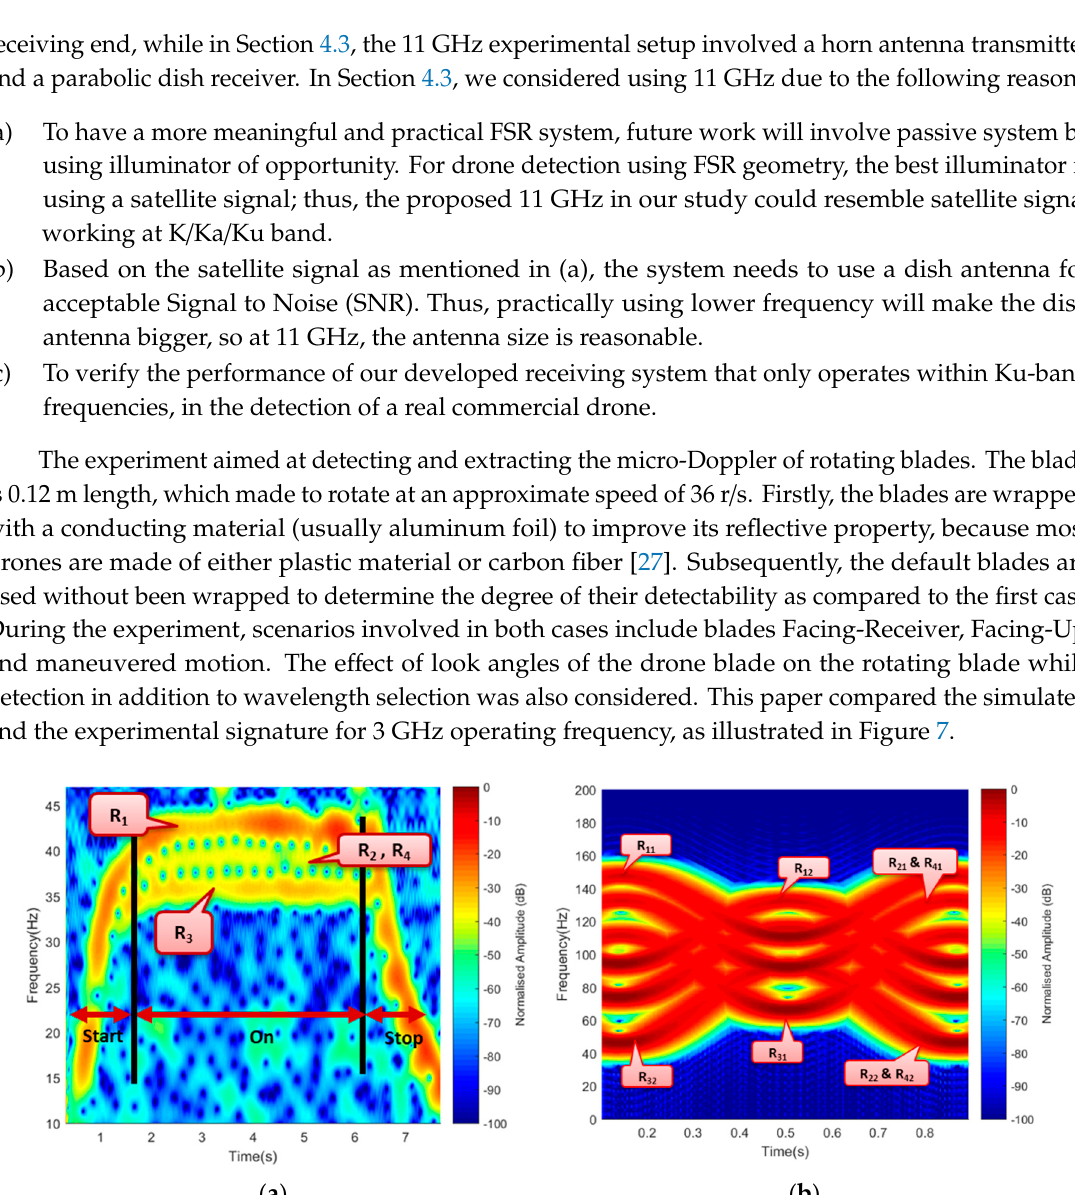
( b ) Figure 8. Outdoor experimental setup ( a ) Facing-Rx ( b ) Facing-Up. Rx: Receiver.